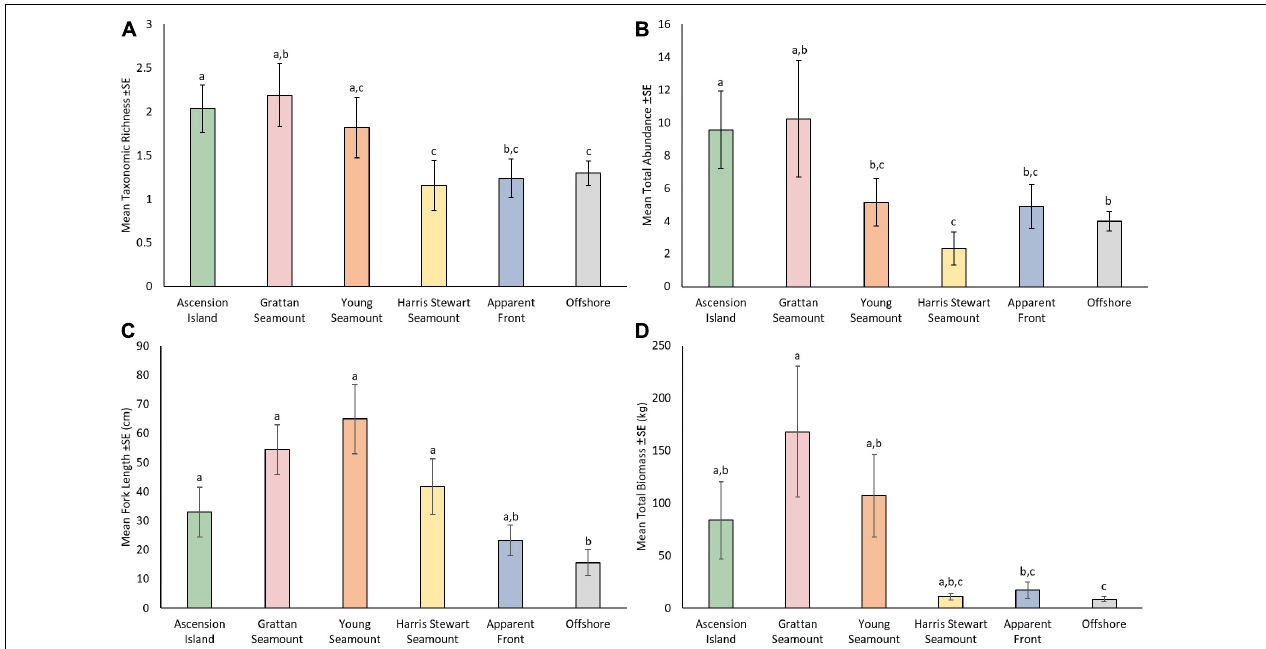
FIGURE 2 | Mean taxonomic richness (A) , mean total abundance (B) , mean fork length (C) , and mean total biomass (D) by feature for all pelagic animals observed on all mid-water BRUVS deployments from Ascension waters in 2017/2018. Shared letters indicate no significant difference ( p > 0.05) based on results of pairwise comparisons from PERMANOVAs based on Euclidean distance matrices of log(x + 1) transformed data with 999 permutations. Error bars indicate one standard error.